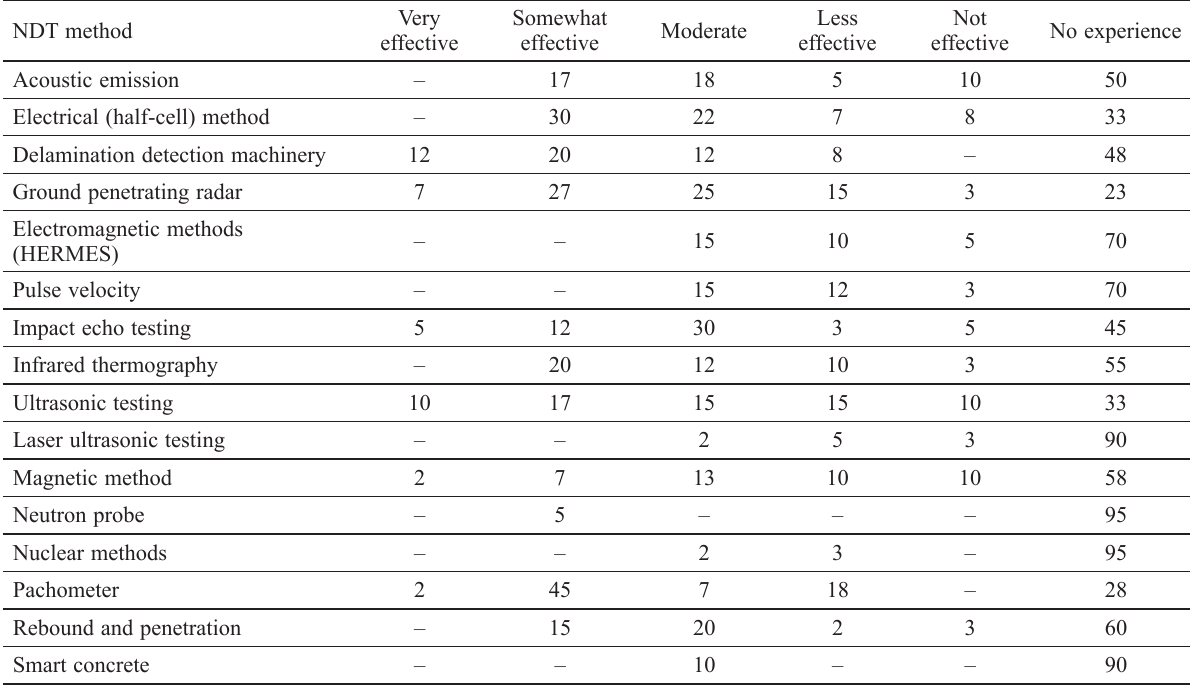
Table 11. Concrete NDT methods: degree of effectiveness NDT method